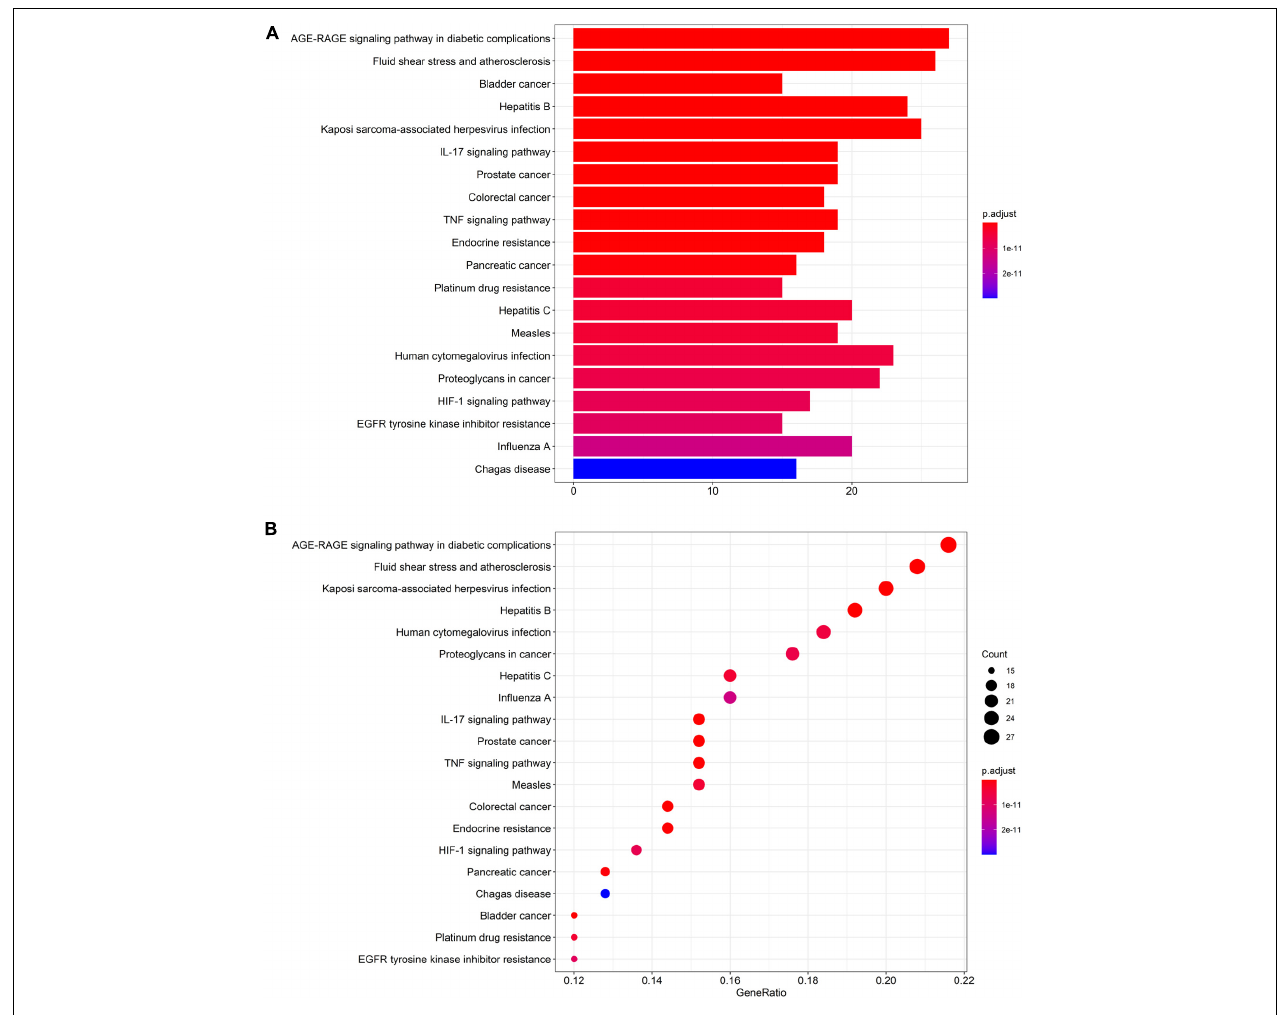
FIGURE 5 | KEGG enrichment analysis of intersection genes. (A) Barplot. (B)